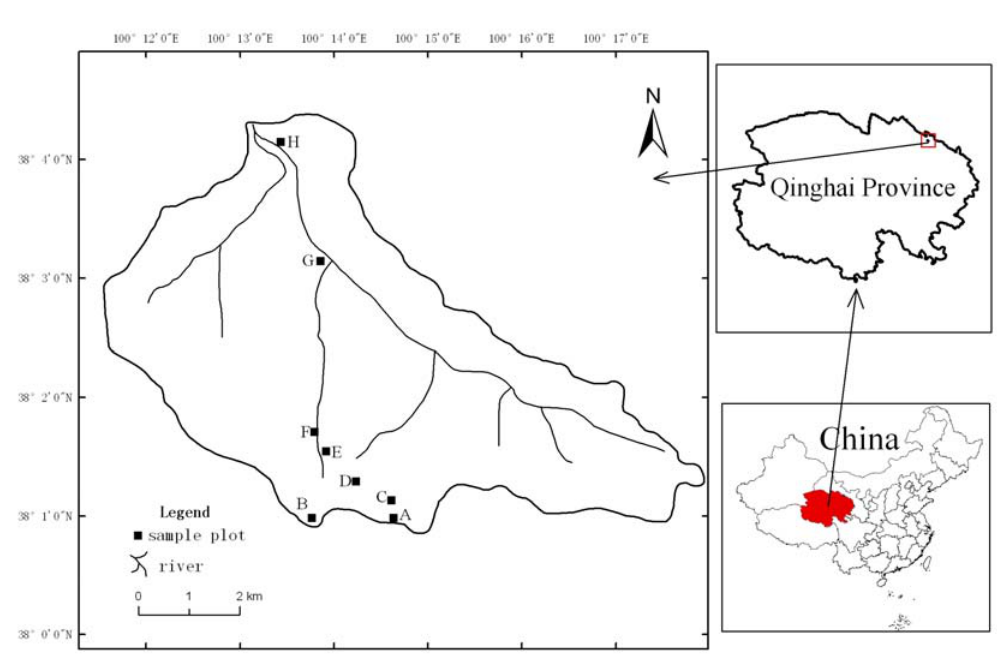
Figure 1. The distribution of the study plots in the Binggou